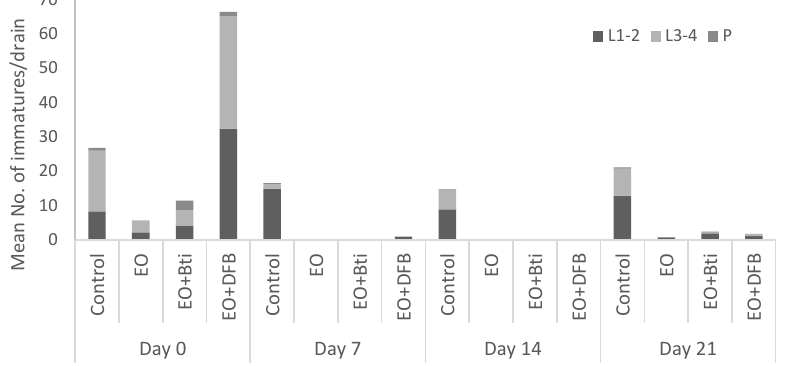
Figure 1. Immature mosquito population (1st–2nd and 3rd–4th instar larvae and pupae) of Cx. pipiens pre-treatment (Day 0) and post-treatment (Days 7, 14, and 21) with oregano essential oil (EO), oregano essential oil + diflubenzuron (EO+DFB), and oregano essential oil + B.t.i. (EO+Bti) in road drains in Crevalcore, Italy, during July 2019.